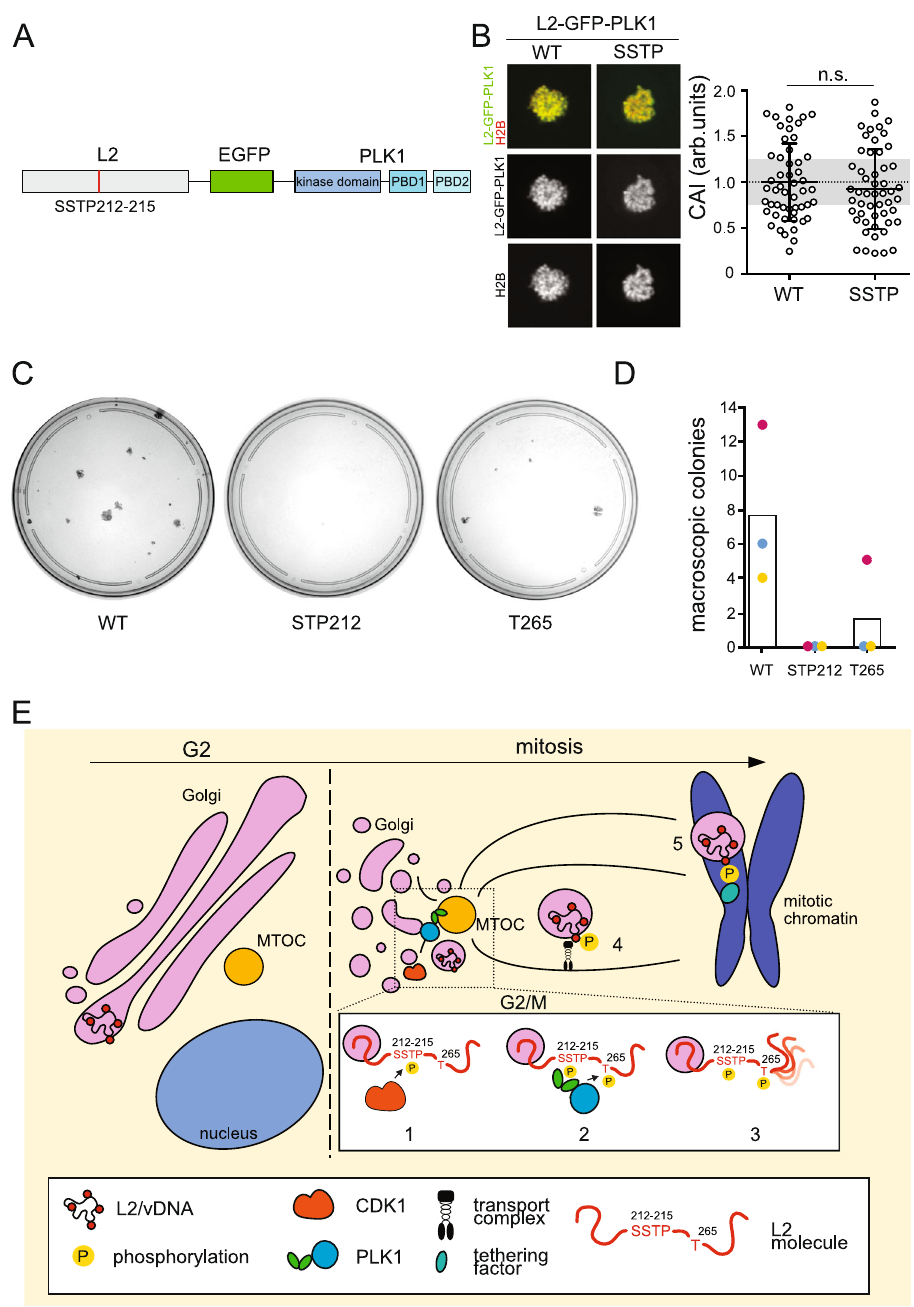
Fig. 6 | CDK1 phosphorylation is primarily required to recruit PLK1 to L2. A Schematic depiction of L2-GFP-PLK1 WT and SSTP212AAAA mutant chimeras generatedtostudychromosomalassociation. B Chromosomalassociationassayof ectopically expressed wild type and SSTP 212 L2-EGFP-PLK1 chimera in HeLa H2B- mCherry cells arrested with nocodazole (330 nM) in mitosis; images display representative single medial planes of spinning disk confocal microscopy with L2- EGFP-PLK1 in green and H2B-mCherry in red as indicated. The chromosomal association index (CAI) of individual cells (circles), i.e. the intensity of H2B- mCherry-overlapping EGFP signal over total intensity 4 . 50 cells from three inde- pendentexperimentswereanalyzed.Displayedistheaverageofthreeindependent experiments ± SD. Statistical signi fi cance was assessed by two-tailed Student ’ s t test. C Quantitative colony formation assay was used to test the ability of HPV18